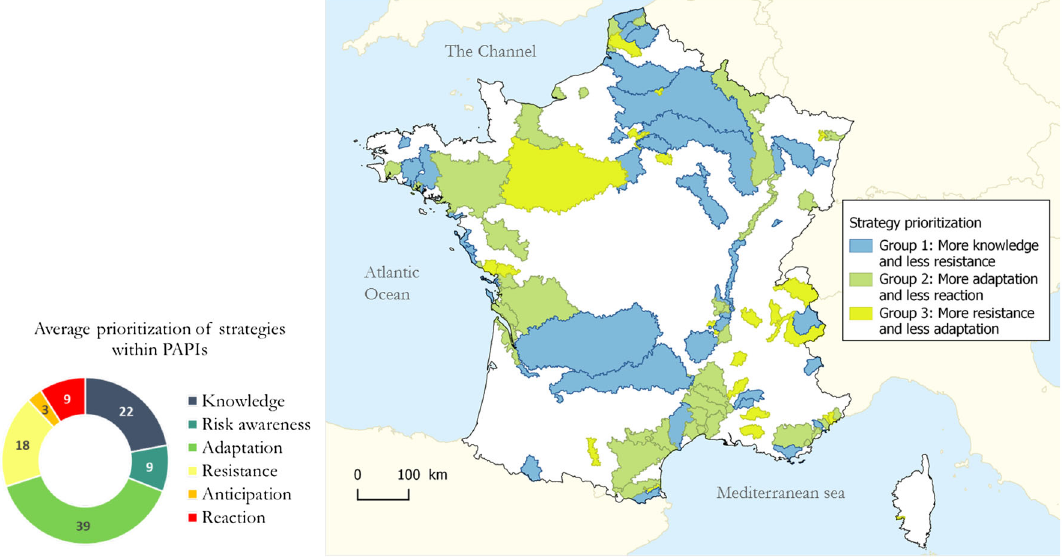
Fig. 6 Average prioritization of strategies in the French Action Programs for Flood Prevention PAPIs (Programme d’Action pour la Pre´vention des Inondations), and the spatial distribution of